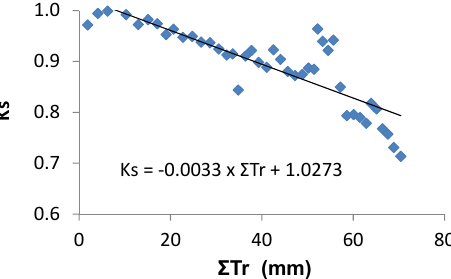
Figure 8. Relationship between Ks and cumulated Tr since the last irrigation in the stressed plot, during a stress cycle in an intensive olive orchard [20] (derived from Ferreira et al. [20]).